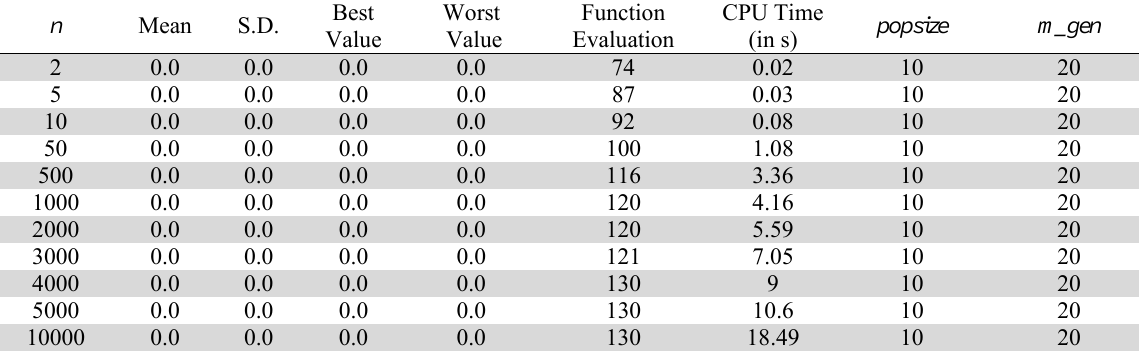
Computational Results of Problem